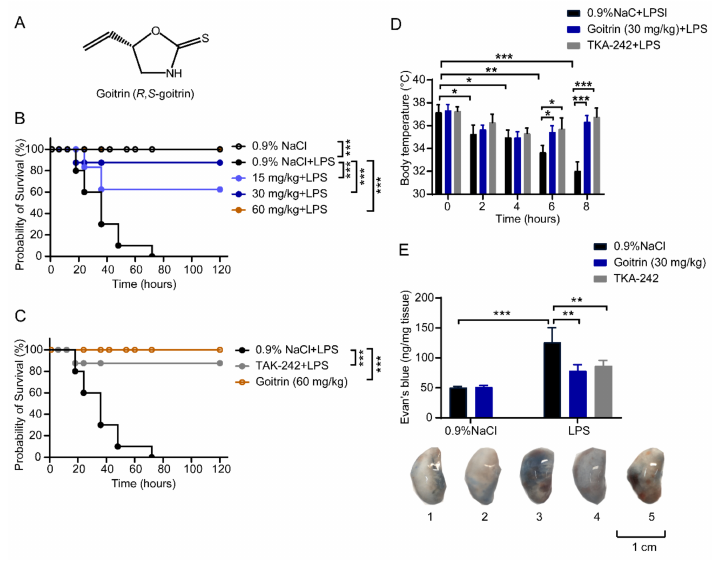
Figure 1. Protective effects of goitrin in LPS-challenged mice. Mice were peritoneally injected with 0.9% NaCl, goitrin (15, 30, or 60 mg/kg) or TAK-242 (3 mg/kg) 1 h before LPS (20 mg/kg)